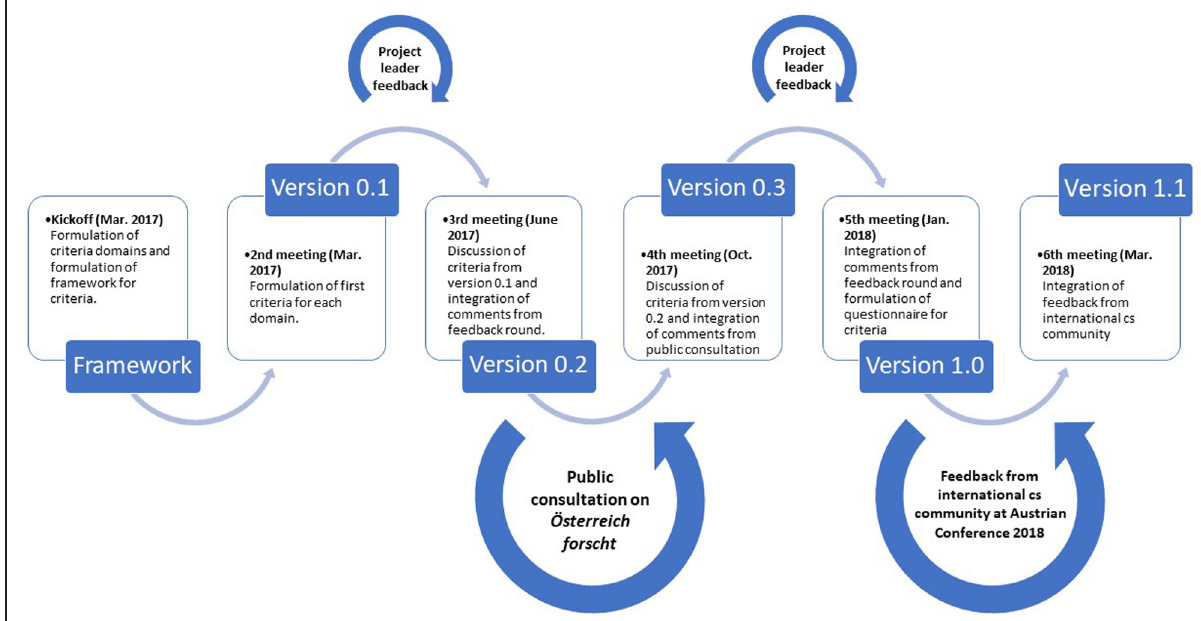
Figure 1: Process of the development of the criteria catalogue. The catalogue was developed over the course of six meetings ( blue framed boxes ). Between meetings 2 and 3, and between 4 and 5, the leaders of projects listed on Öster- reich forscht were asked to comment on the respective versions (project-leader feedback). Between meetings 3 and 4, a public consultation on Version 0.2 of the criteria was held on the website Österreich forscht to give interested citizens the opportunity to comment on the criteria. At meeting 6, feedback collected from the international